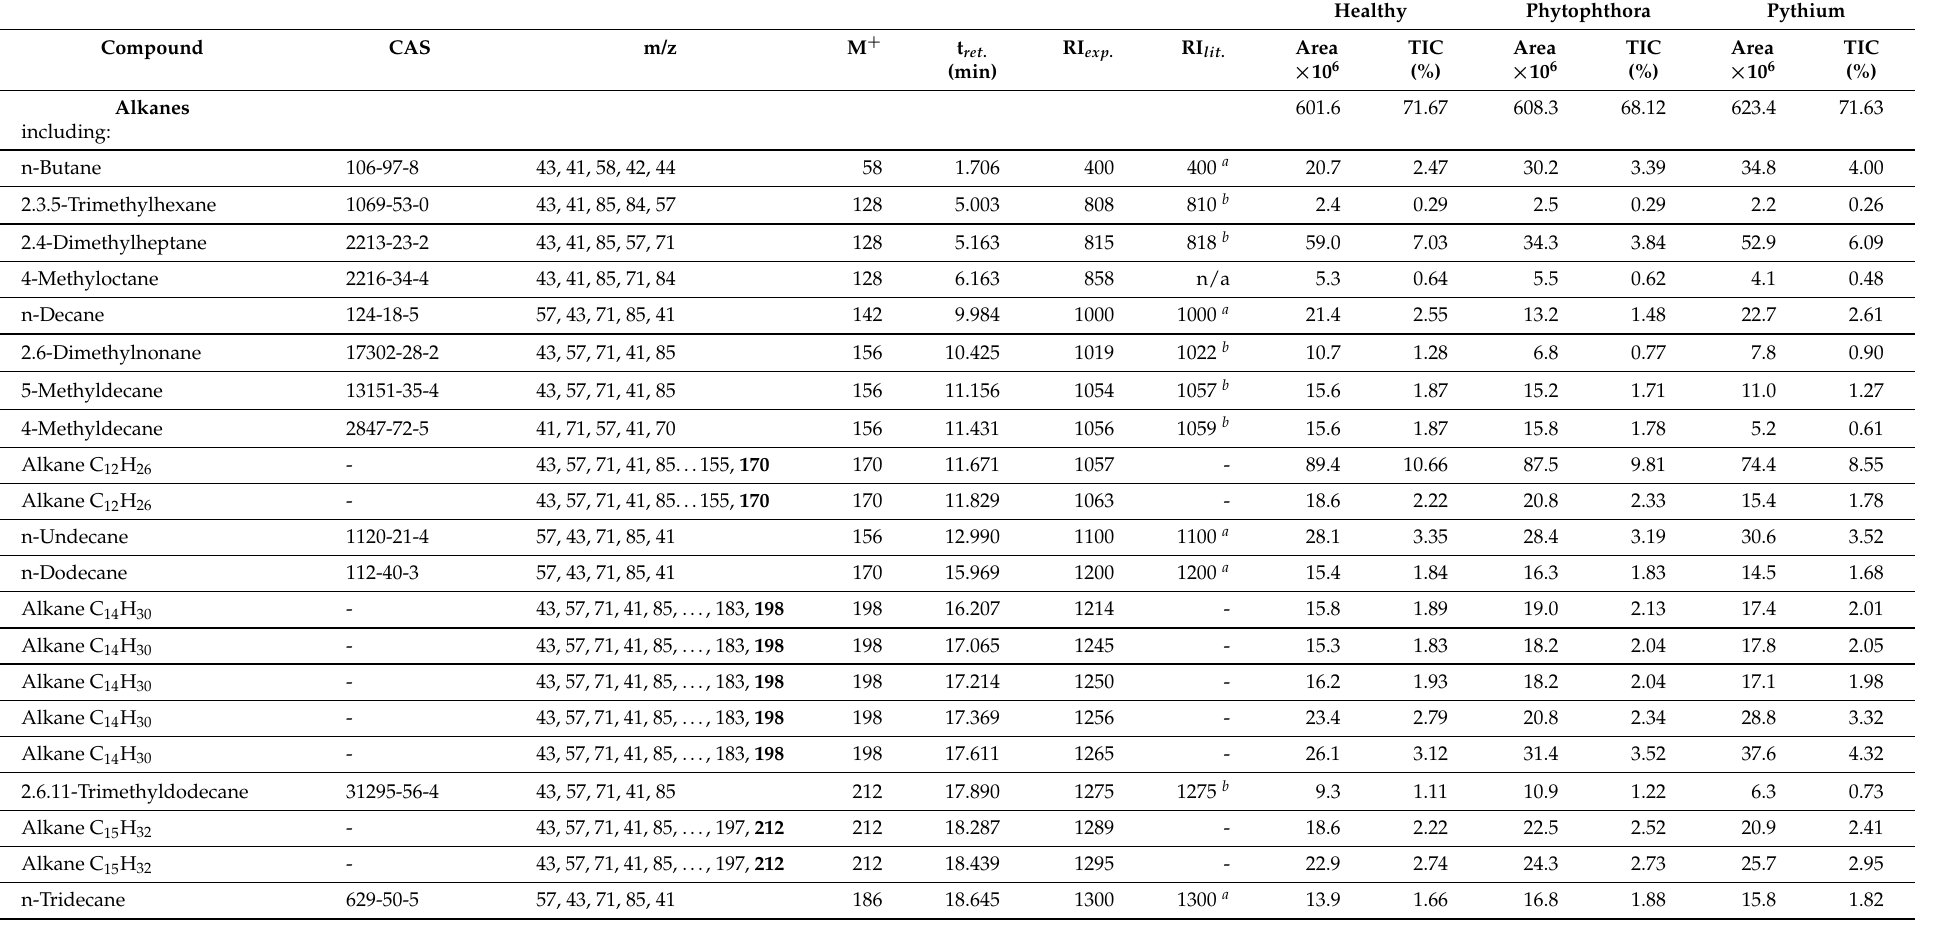
Table A1. The chemical components identified by the Gas Chromatography-Mass Spectrometry measurements. By the blue color are highlighted the components specific to the considered category of samples. The meaning of columns is defined in Table